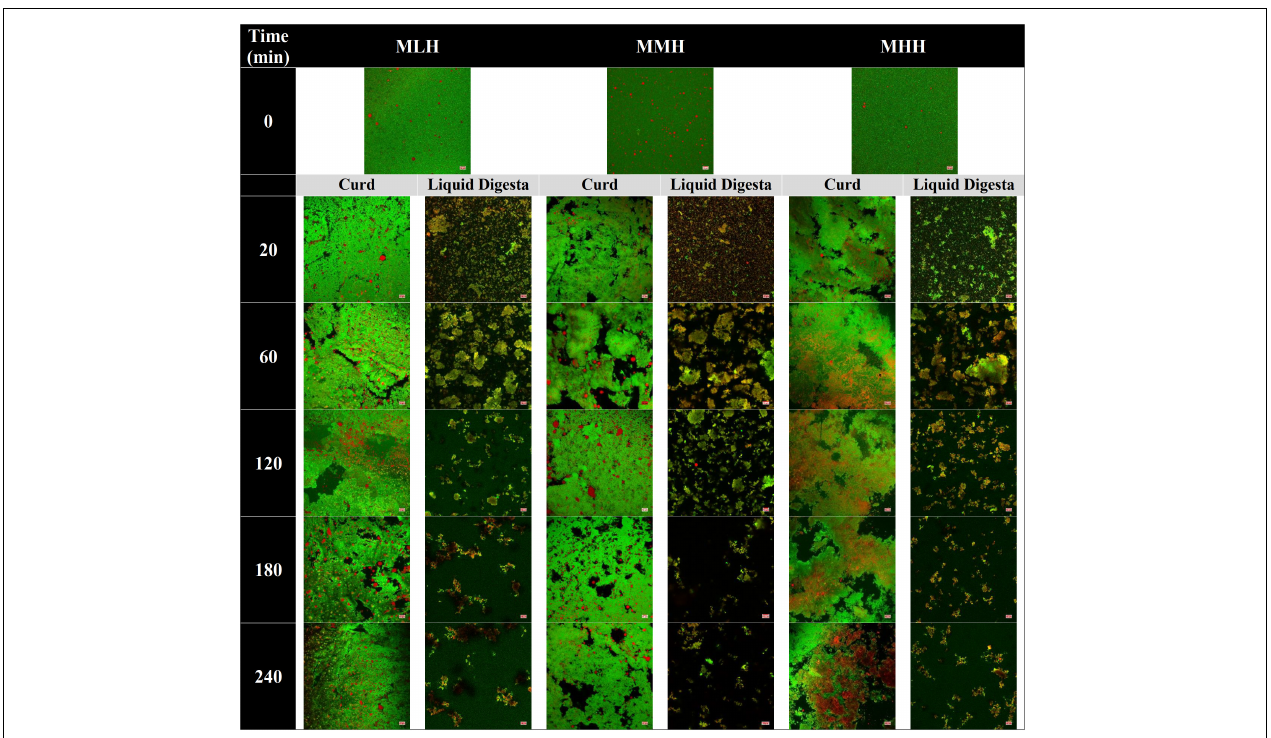
FIGURE 2 | Confocal microscopy images of gastric curd and liquid digesta formed at 0, 20, 60, 120, 180, and 240 min of gastric digestion of low-heat (MLH), medium-heat (MMH), and high-heat (MHH) recombined milk systems. Red shows the oil droplets and green shows the milk proteins. The scale bar corresponds to 10 µ m for all